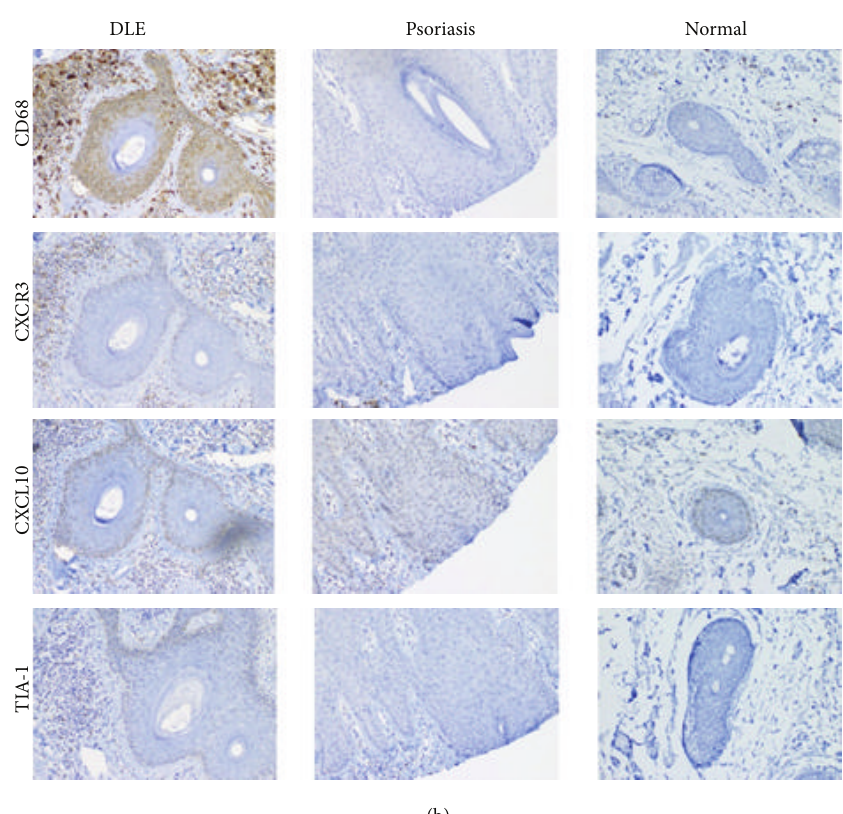
Figure 3: Comparisons of staining of T cell, B cell, and macrophage markers (CD3, CD4, CD8, CD20, CD68, CXCR3, CXCL10, and TIA-1) in the periadnexal area of DLE lesional skin ( 𝑁 = 23 ), psoriasis lesional skin ( 𝑁 = 11 ), and normal skin ( 𝑁 = 5 ). (a) DLE lesional skin expressed higher levels of all the markers studied in the periadnexal area compared with psoriasis lesional skin. ∗ 𝑃 < 0.01 ; ∗∗ 𝑃 < 0.001 ; ∗∗∗ 𝑃 < 0.0001 .(b) H&E and various immunostainings showed that DLE lesional skin expressed higher levels of all the markers studied in the periadnexal area compared with psoriasis lesional skin. Magnification: 100x.